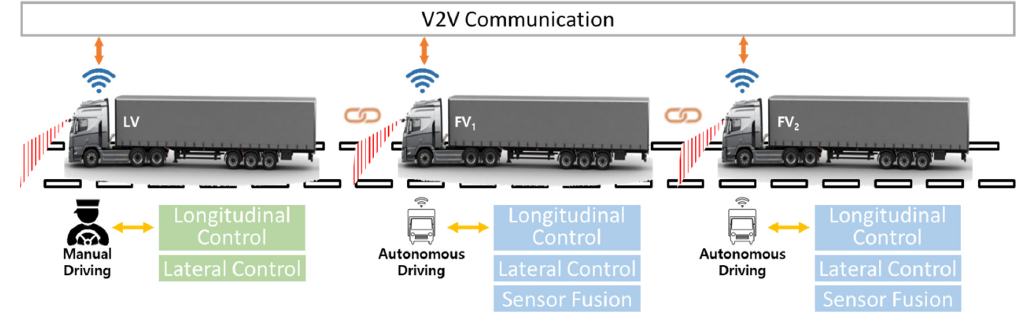
Figure 1. Overall architecture of truck platooning system.